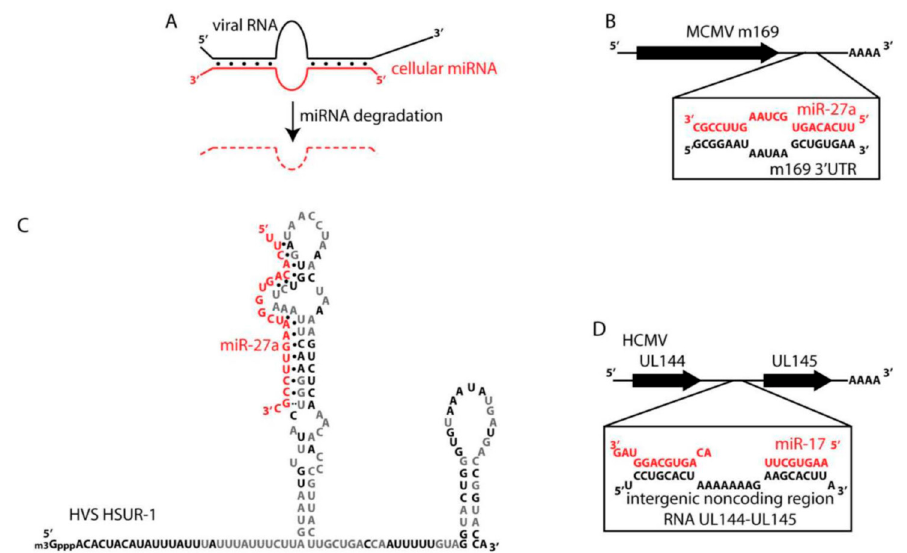
Figure 5. Viral RNAs can induce cellular miRNA degradation. ( A ) Generalized scheme showing a viral RNA (in black) bound to a cellular miRNA (in red). In at least three documented examples this type of binding induces miRNA degradation. ( B ) The 3’ UTR of mouse cytomegalovirus (mCMV) m169 binds to and induces the degradation of miR-27 in host cells. ( C ) The noncoding RNA of herpesvirus saimiri (HVS) HSUR-1 also binds to and induces the degradation of miR-27. The sequence and predicted secondary structure of HSUR-1 are shown. Black nucleotides are perfectly conserved in all available genome sequences from independent isolates of HVS A, B, and C strains and also in Herpesvirus ateles . Predicted basepairs and non-canonical basepairs are by black dots or double dots, respectively. ( D ) The intergenic noncoding region in UL144-145 RNA of human cytomegalovirus (hCMV) binds and induces the degradation of miR ‐ 17.